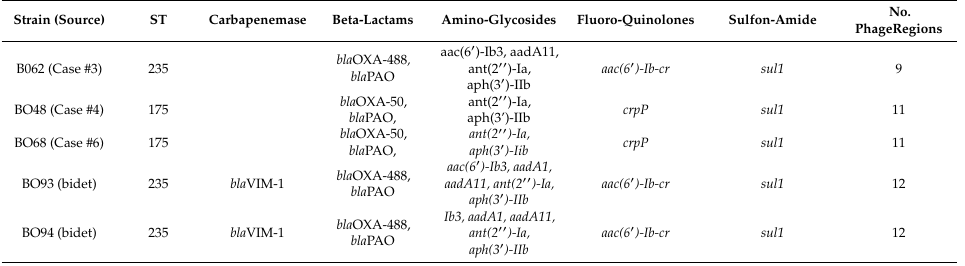
Table 3. Genotypic characteristics of Pseudomonas aeruginosa strains isolated from patients and the